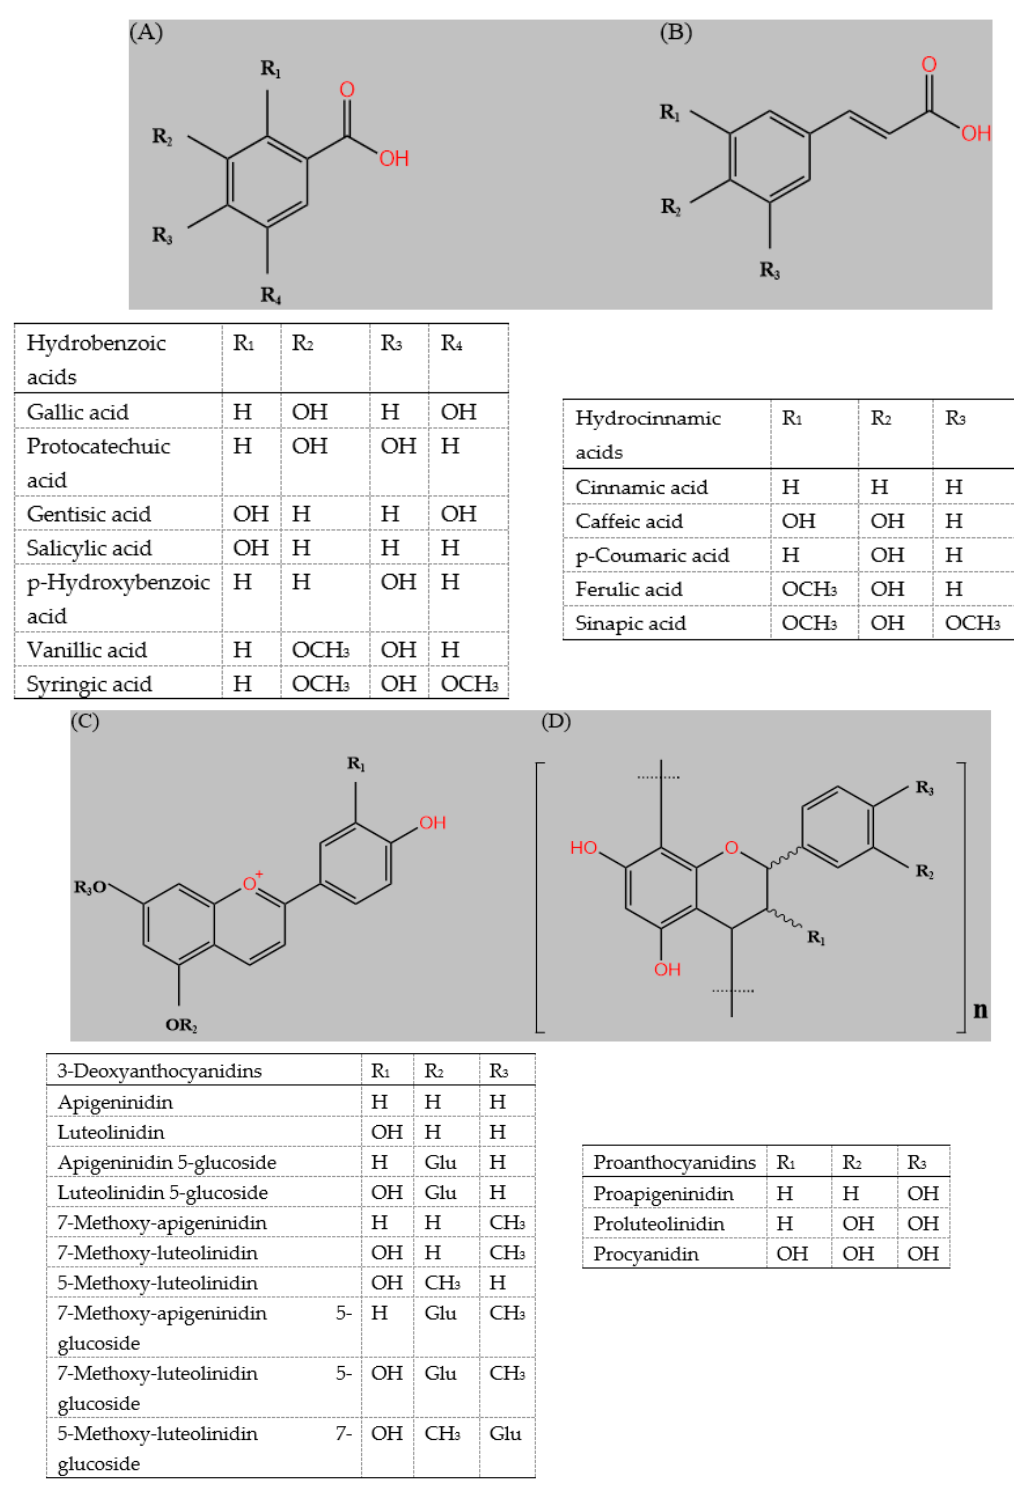
Figure 2. Structure of the hydrobenzoic acids ( A ), hydrocinnamic acids ( B ), 3-Deoxyanthocyanidins ( C ) and proanthocyanidins ( D ) in sorghum grains [3,6,15,17,18].